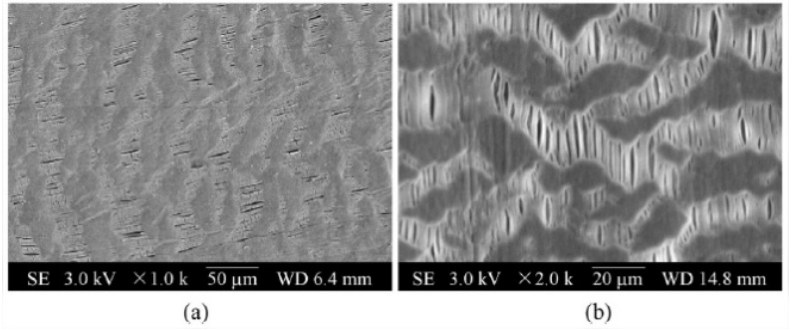
Figure 30. Schematic diagram of the effect of ultrasonic radiation on reducing the formation of silica scale [140].